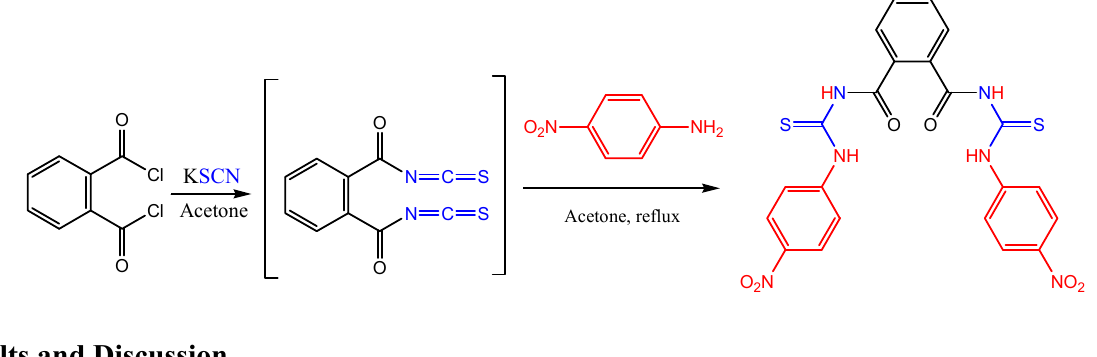
Figure 1. UV-Vis spectra of title compound (5 × 10 − 5 mol L − 1 ) after addition of different anions (none, F − , Cl − , Br − , I − , OAc − , H